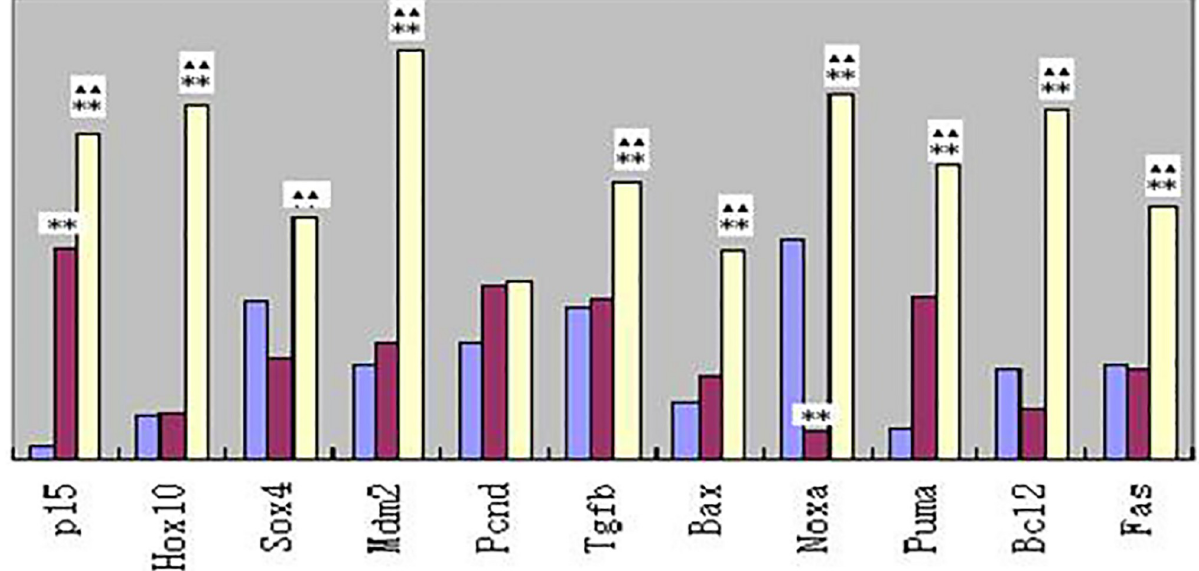
Fig 4. Relative mRNAs levels of 11 selected genes that promote cell apoptosis, cell cycle inhibition, or relative regulation of carcinogenesis. Double stars( �� ) and stars( ▲▲ ) are same as Fig 2. https://doi.org/10.1371/journal.pone.0209014.g004 PLOS ONE | https://doi.org/10.1371/journal.pone.0209014 December13,